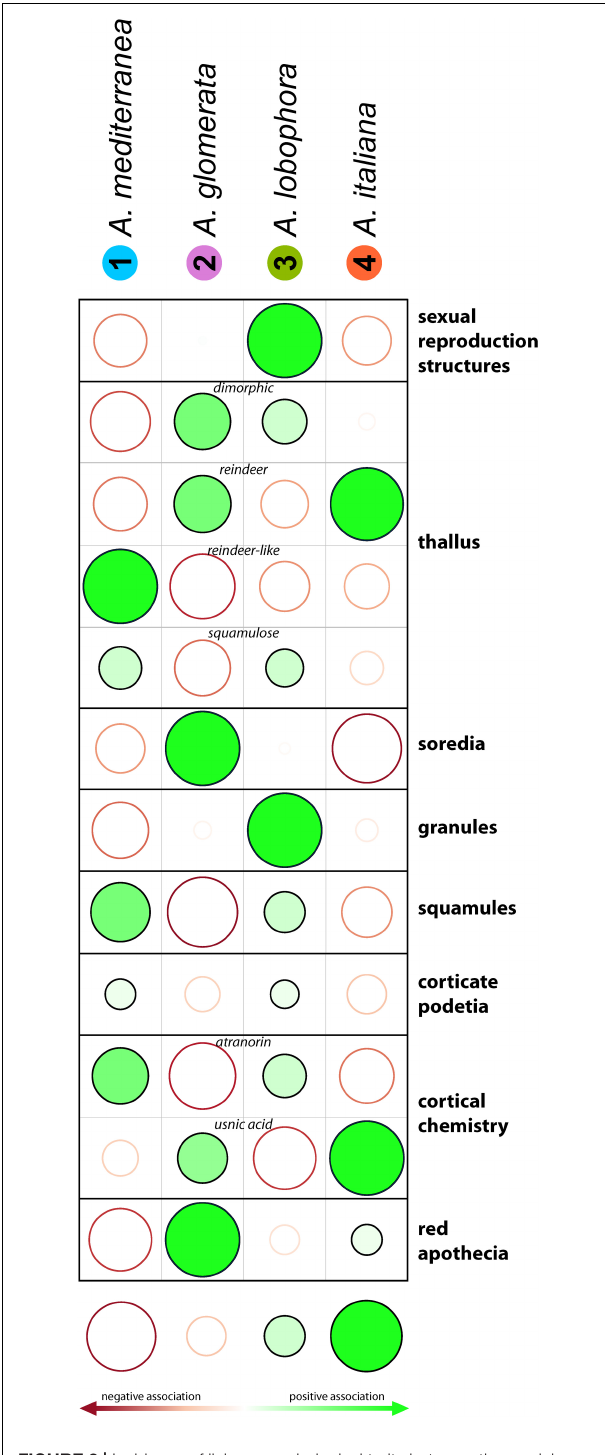
FIGURE 8 | Incidence of lichen morphological traits between the modules. Filled and empty circles display positive and negative associations between the module assignment and the trait values. Stronger associations are shown by larger circles and darker colors. The darker the color, the more distinct the observed value than the expected value if the data were random (calculated by Chi-squared test). The size of the circle is proportional to the amount of the cell